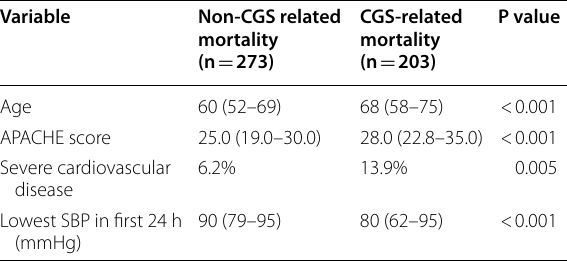
Table 1. Factors associated with cardiogenic shock